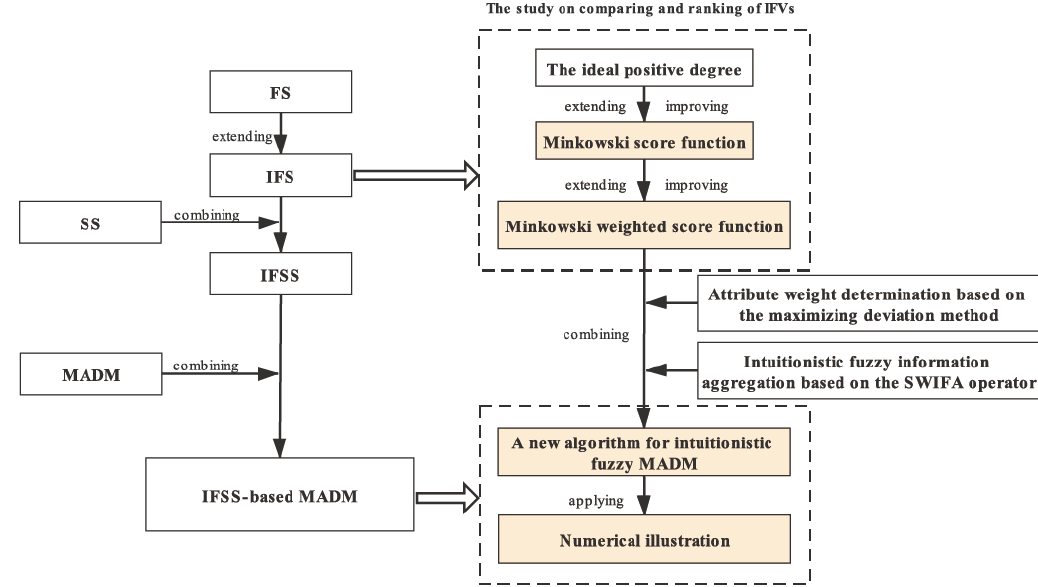
Figure 1. Workflow and framework of this study. IFSS, intuitionistic fuzzy soft set; MADM, multiple attribute decision making (MADM); SWIFA, simply weighted intuitionistic fuzzy